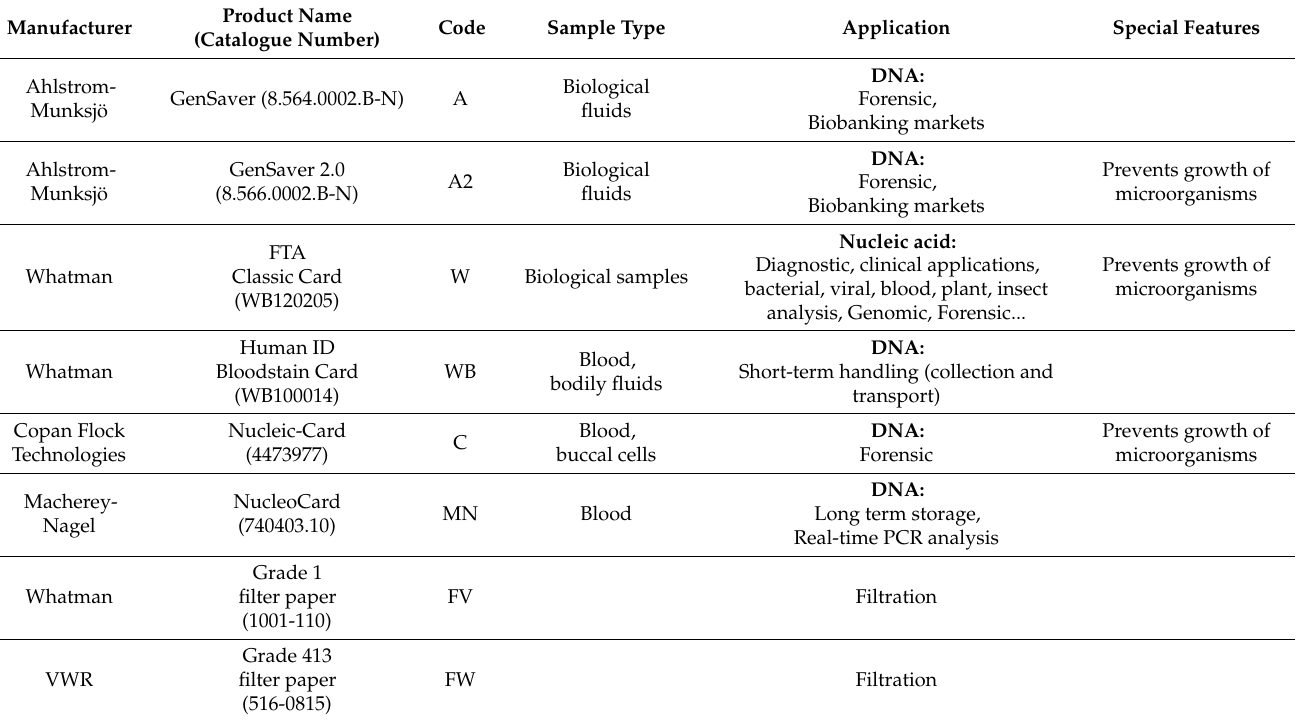
Table 2. Biosample collection cards and filter papers used in the